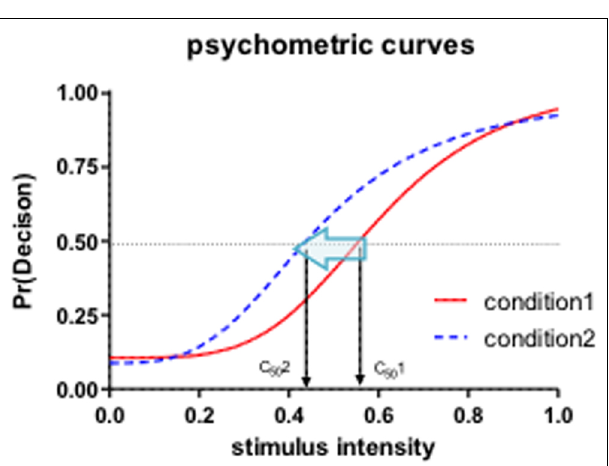
FIGURE 3 | Psychometric curves (Naka-Rushton contrast response model). X-axis represents stimulus intensity and Y-axis represents response probability. In our experiments, the stimulus intensity represents the incremental increase of emotional expressions (neutral to happy; neutral to angry) of morphed faces and the response represents the proportion of happy or angry decisions. The C 50 or PSE (point of subjective equality) parameter indicates the perceptual decision threshold. A leftward shift of the psychometric curve would constitute evidence for decreased perceptual